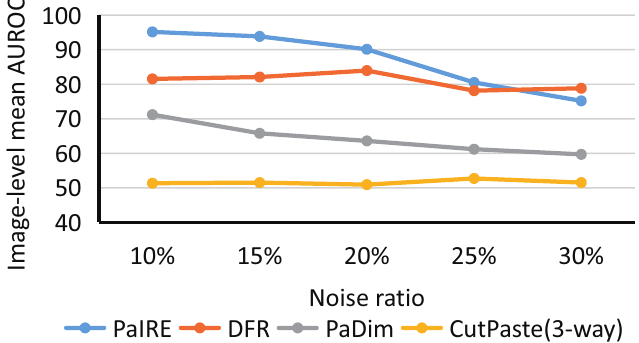
Figure 12. Comparison on KSDD2